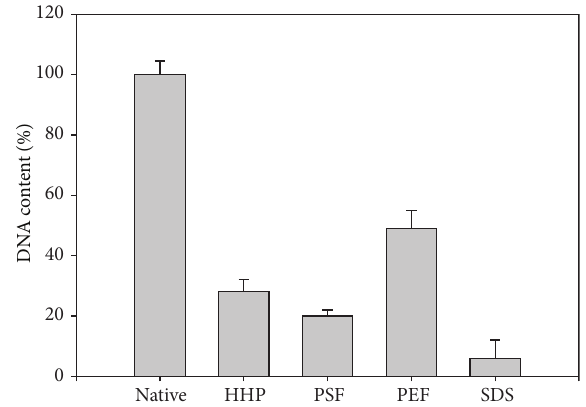
Figure 5: Average residual DNA content of the analyzed specimen treated with various